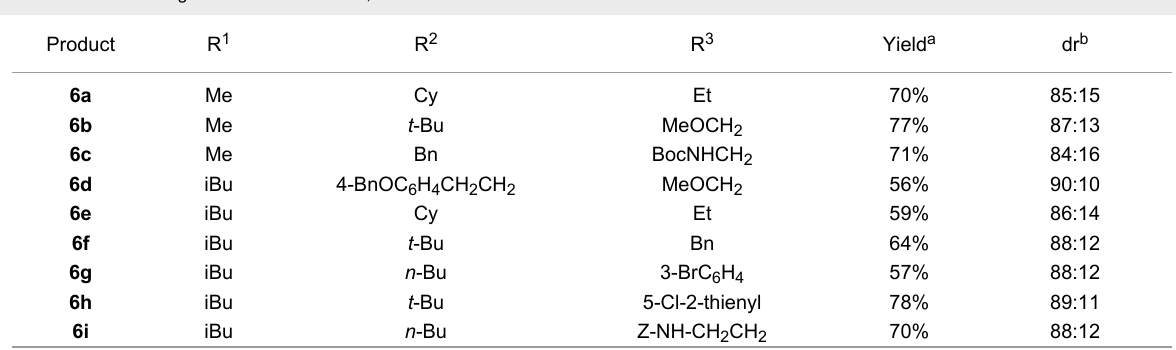
Table 1: Results of Ugi reactions of imines 5a , b .